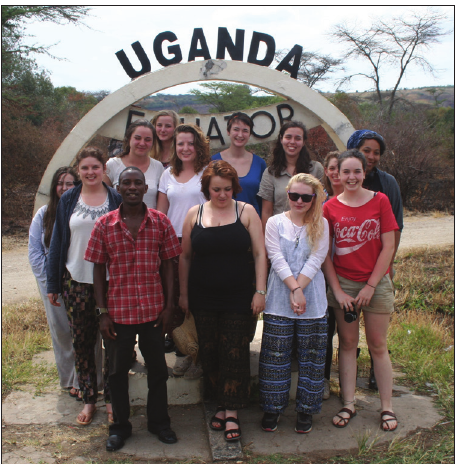
Figure 1: The Studies in African Field Archaeology Class, ARCL2040, crossing the equator (for the 6th time!), February 2015.